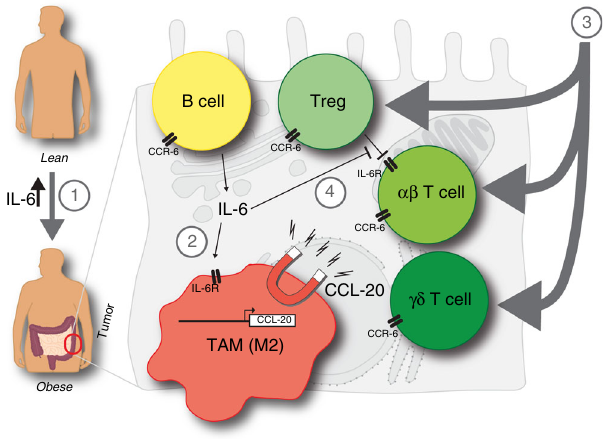
Fig. 8 Mechanism how obesity and IL-6 alter the colitis-associated tumour microenvironment. 1. Obesity-induced gut barrier defects cause a low- grade in fl ammation including increases in IL-6 levels. 2. IL-6 polarises macrophages towards M2-type in colitis-associated colorectal cancer (CAC) that in response to commensal factors express the chemoattractant CCL-20. 3. CCL-20 recruits CCR-6-expressing lymphocytes comprising B cells, regulatory T cells (Treg) and T cells expressing αβ and γδ T-cell receptors that impact on CAC progression. B cells impact on macrophage polarisation, whereas CCR-6 + γδ T cells provide pathogenic IL-17. 4. IL-6 signalling in αβ T cells releases them from Treg-mediated suppression to exert their effector functions such as T helper (Th)1 and Th17